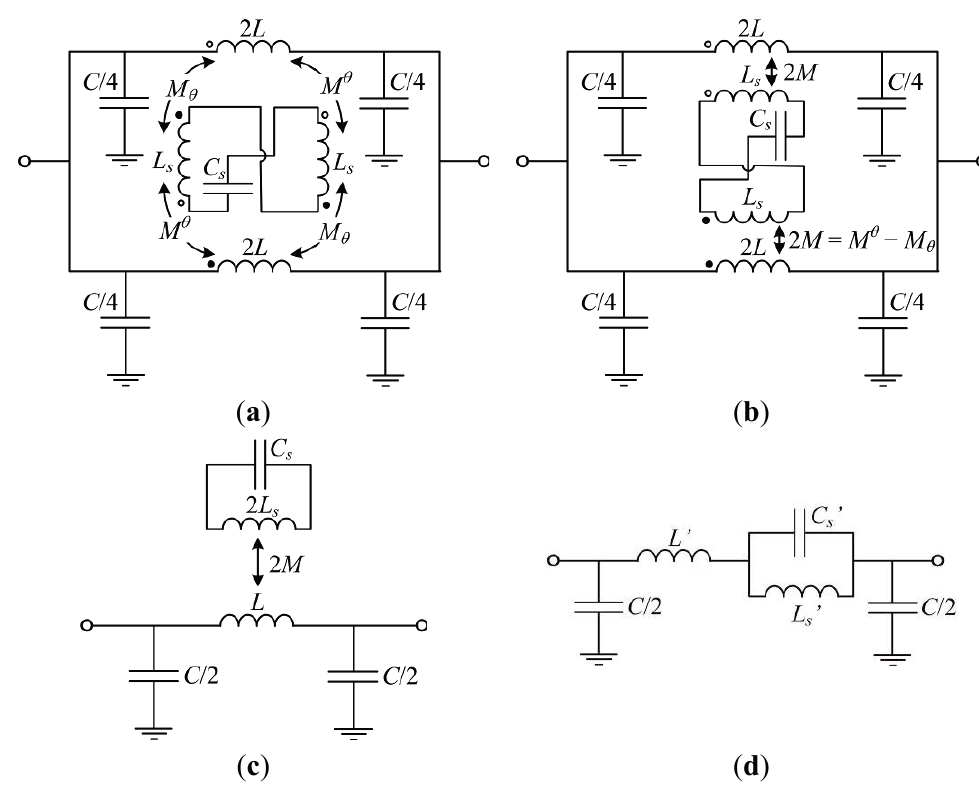
Figure 4. Proposed lossless angle-dependent equivalent circuit model of an S-SRR-loaded CPW. Model with the CPW symmetrically split ( a ) where different magnetic coupling mechanisms are identified and ( b ) where an effective magnetic coupling is considered; ( c ) Simplified model and ( d ) equivalent transformed model. Further details on the derivation of the original circuit models corresponding to an ELC-loaded CPW can be found in